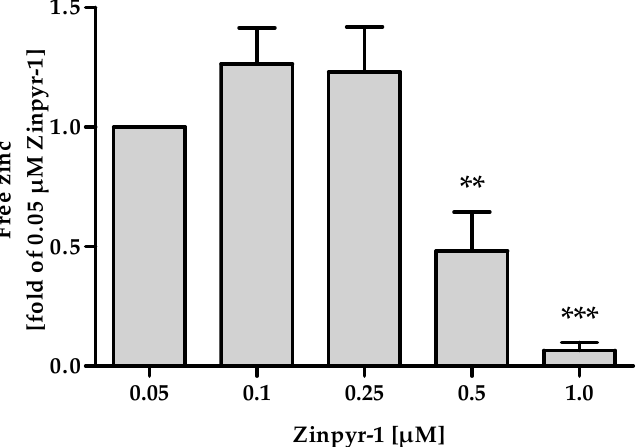
Figure 5. Effect of Zinpyr-1 concentration on free zinc measurements. The final assay procedure was performed as described in Materials and Methods, using the indicated concentrations of Zinpyr-1. Data are shown as means ±SD of n = 3 independent experiments. Significant differences to the mean measured for 0.05 µM Zinpyr-1 are indicated (** p < 0.01, *** p < 0.001; one-way analysis of variance (ANOVA) with Bonferroni post hoc test).